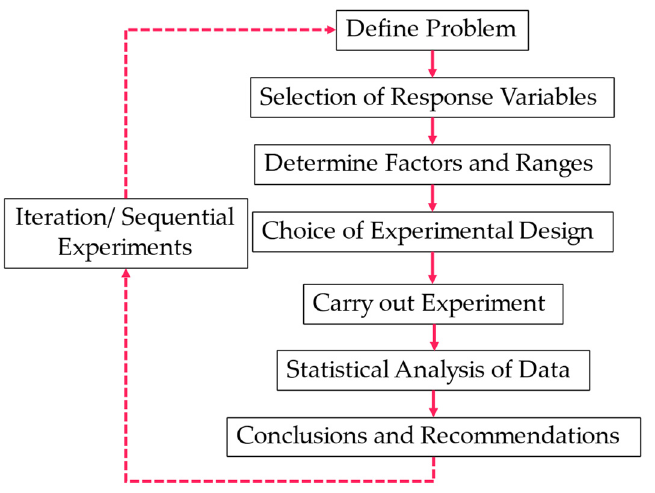
Figure 1. A generalised semi-structured framework for a DoE approach to formulation of polyurethane foams.